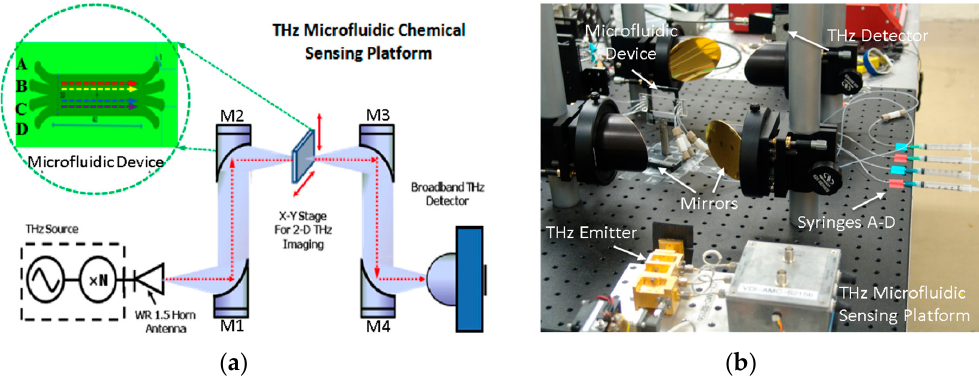
Figure 1. The THz microfluidic chemical sensing and imaging platform: ( a ) a schematic of the system comprising a quasi-optical THz-FDS spectroscopy and a four-channel microfluidic subsystem; ( b ) a photo showing the actual experimental setup. Liquid samples are delivered to the microfluidic chip through the four syringes A–D [26].